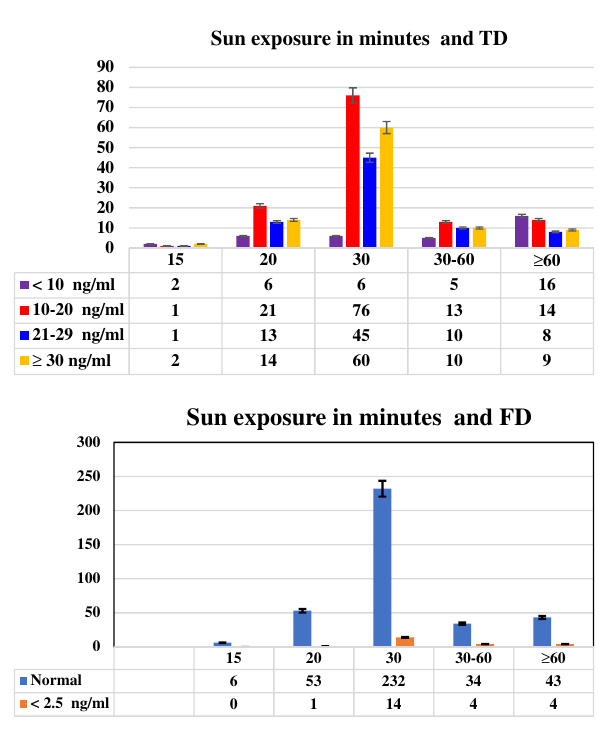
Figure 5. Total and Free 25-OHD in respect to exposure to sun